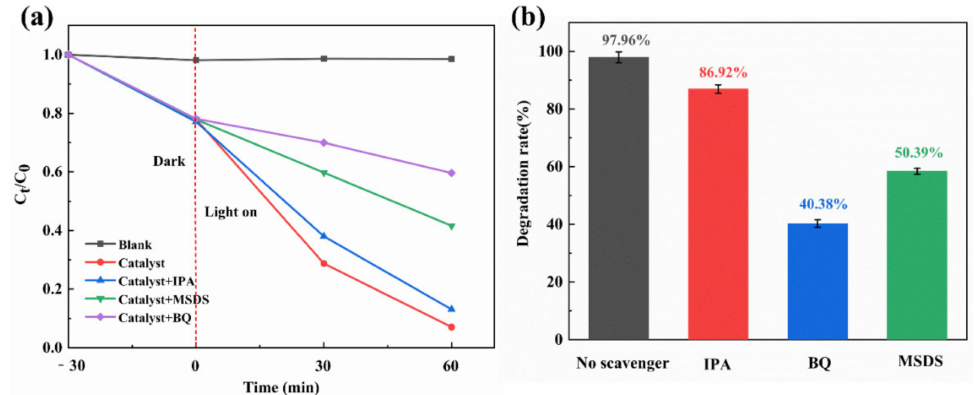
Figure 10. ( a ) Free radical scavenging experiment of AB/AC@Z3. ( b ) Degradation rate of RhB after adding different kinds of